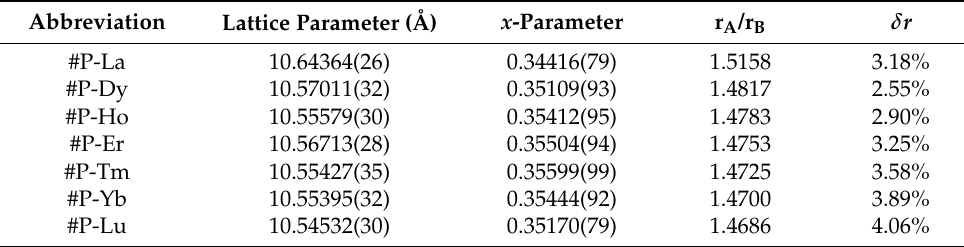
Table 2. Main parameters of the seven